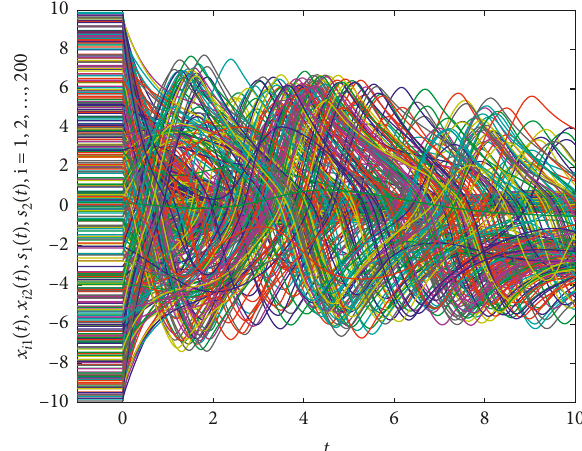
Figure 14: Time evolution of nodes’ states x without the control, i � 1 , 2 , .. . ,